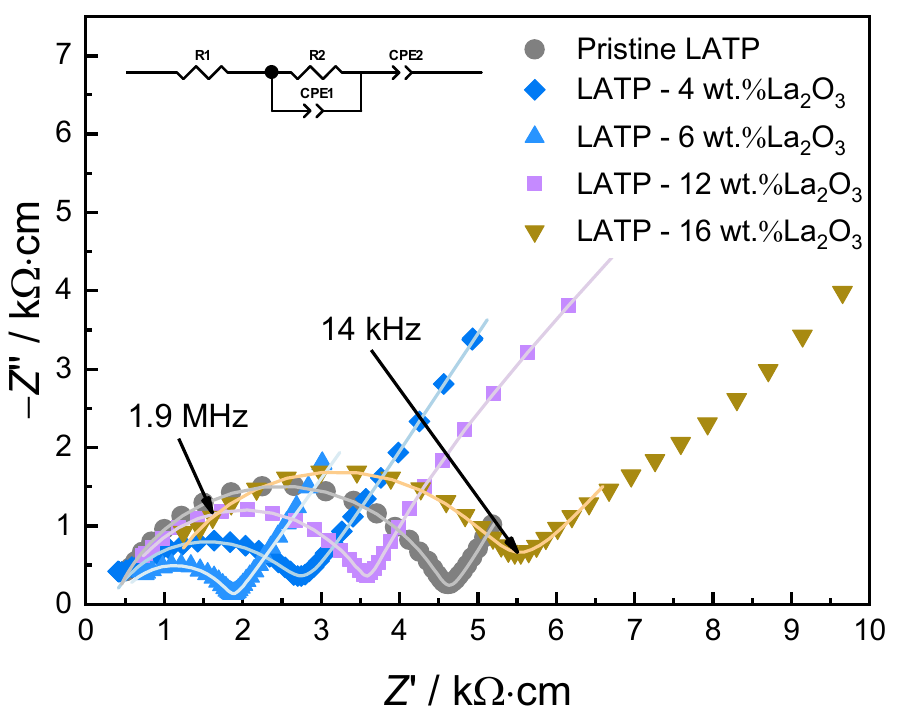
Figure 3. Nyquist plots of pristine LATP and composite samples with fitted curves. The related equivalent circuit is shown in the inset.